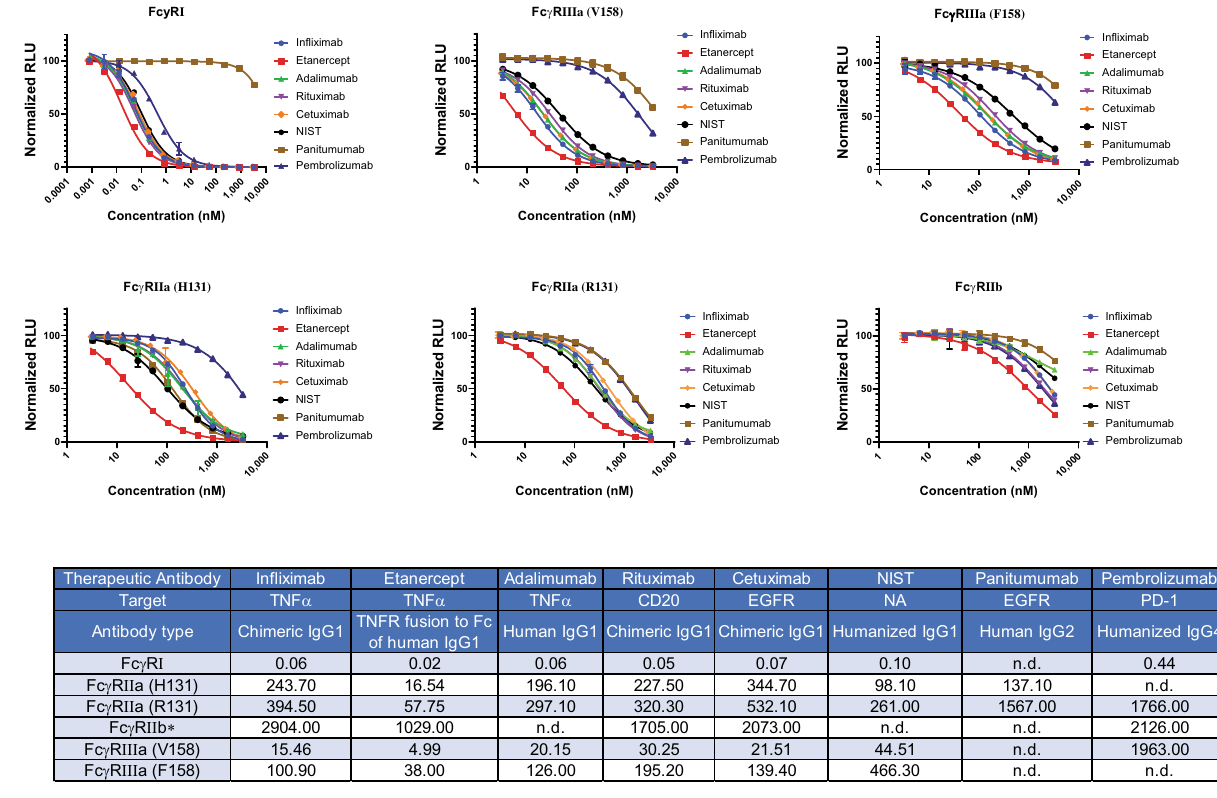
Figure 5. Dose dependent inhibition curves generated with six different NanoBiT FcγR assays. A diverse set of therapeutic antibodies were tested along with one NIST mAb standard. Data represent the mean ± standard error of triplicate experiments. IC 50 (nM) values calculated from the inhibition curves are shown in the Table. IC 50 values are in nM. *For FcγRIIb, IC 50 values are intended only for qualitative purposes as mentioned in the text. n.d. not determined.